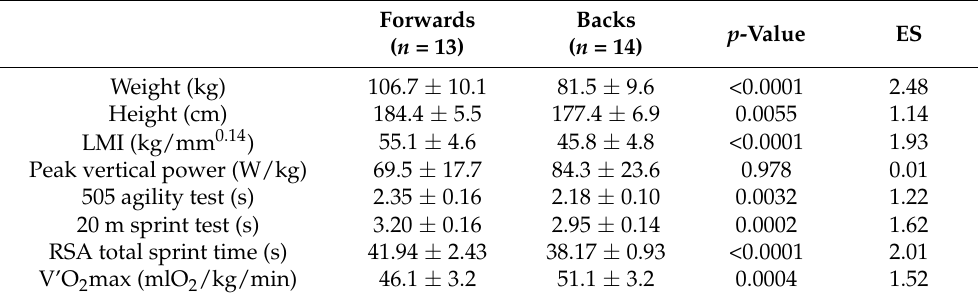
Forwards Backs p -Value ES ( n = 13) ( n = 14)